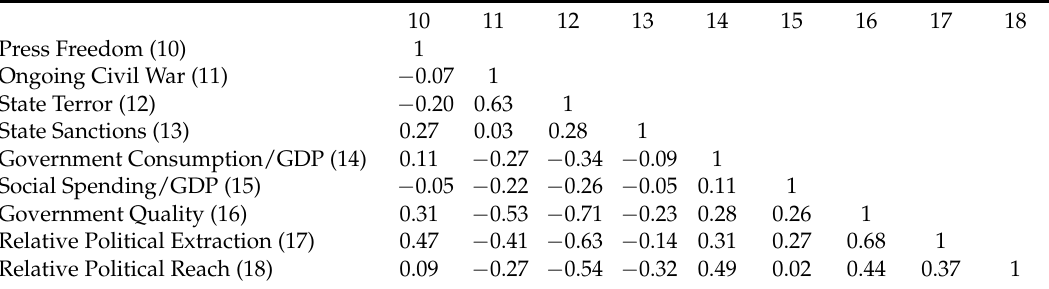
Table A2. Correlation Matrix of All Independent Variables